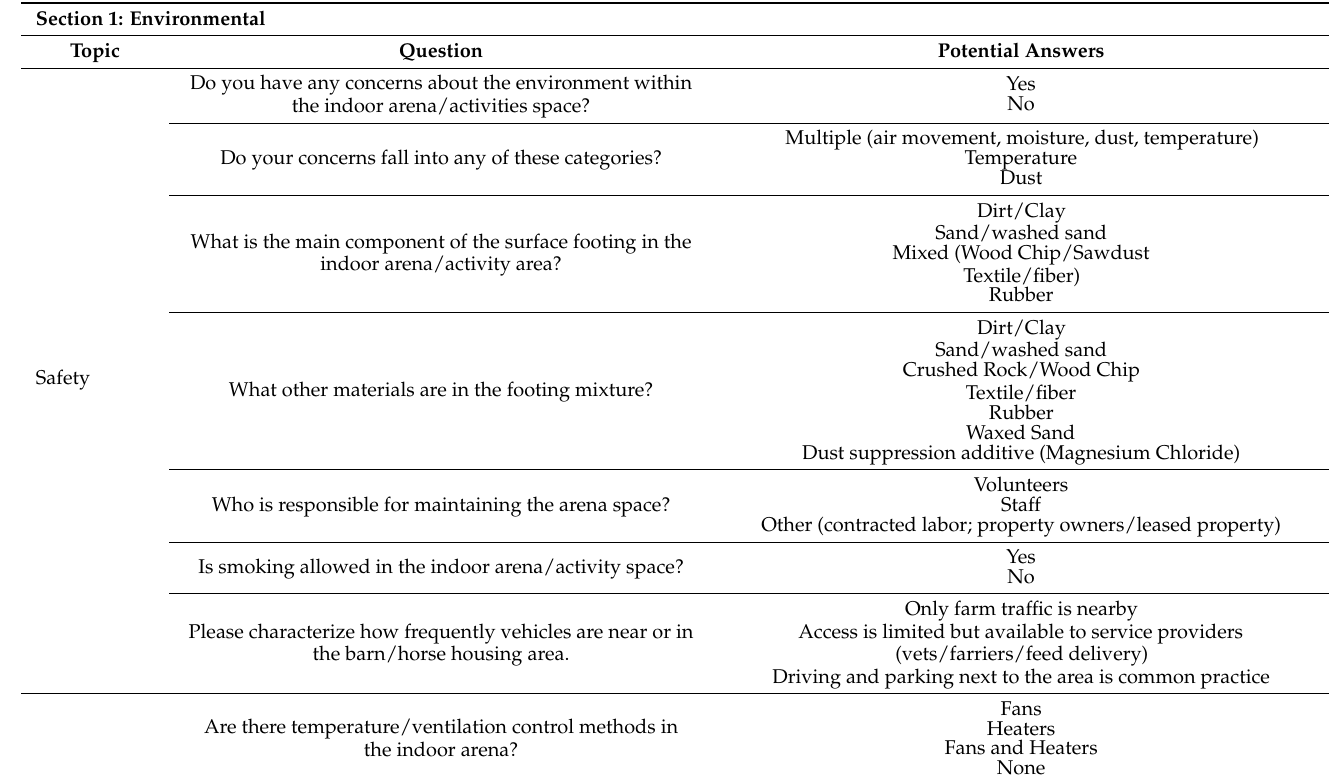
Table 1. Selected survey topics, questions, and potential answers for each